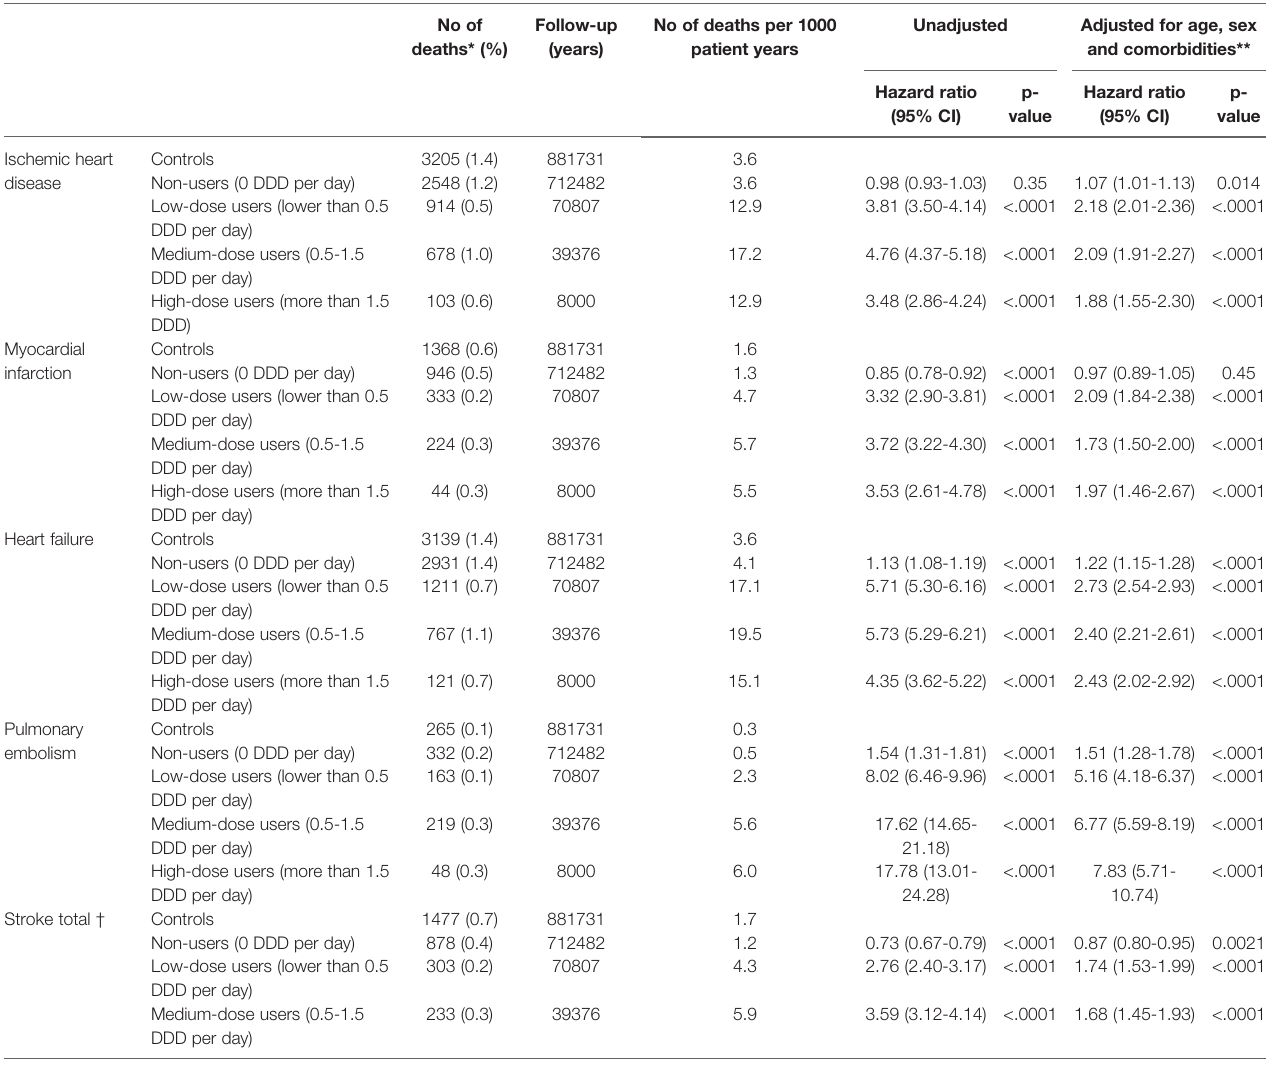
TABLE 5 | Disease-speci fi c mortality in GC users compared to age- and sex-matched